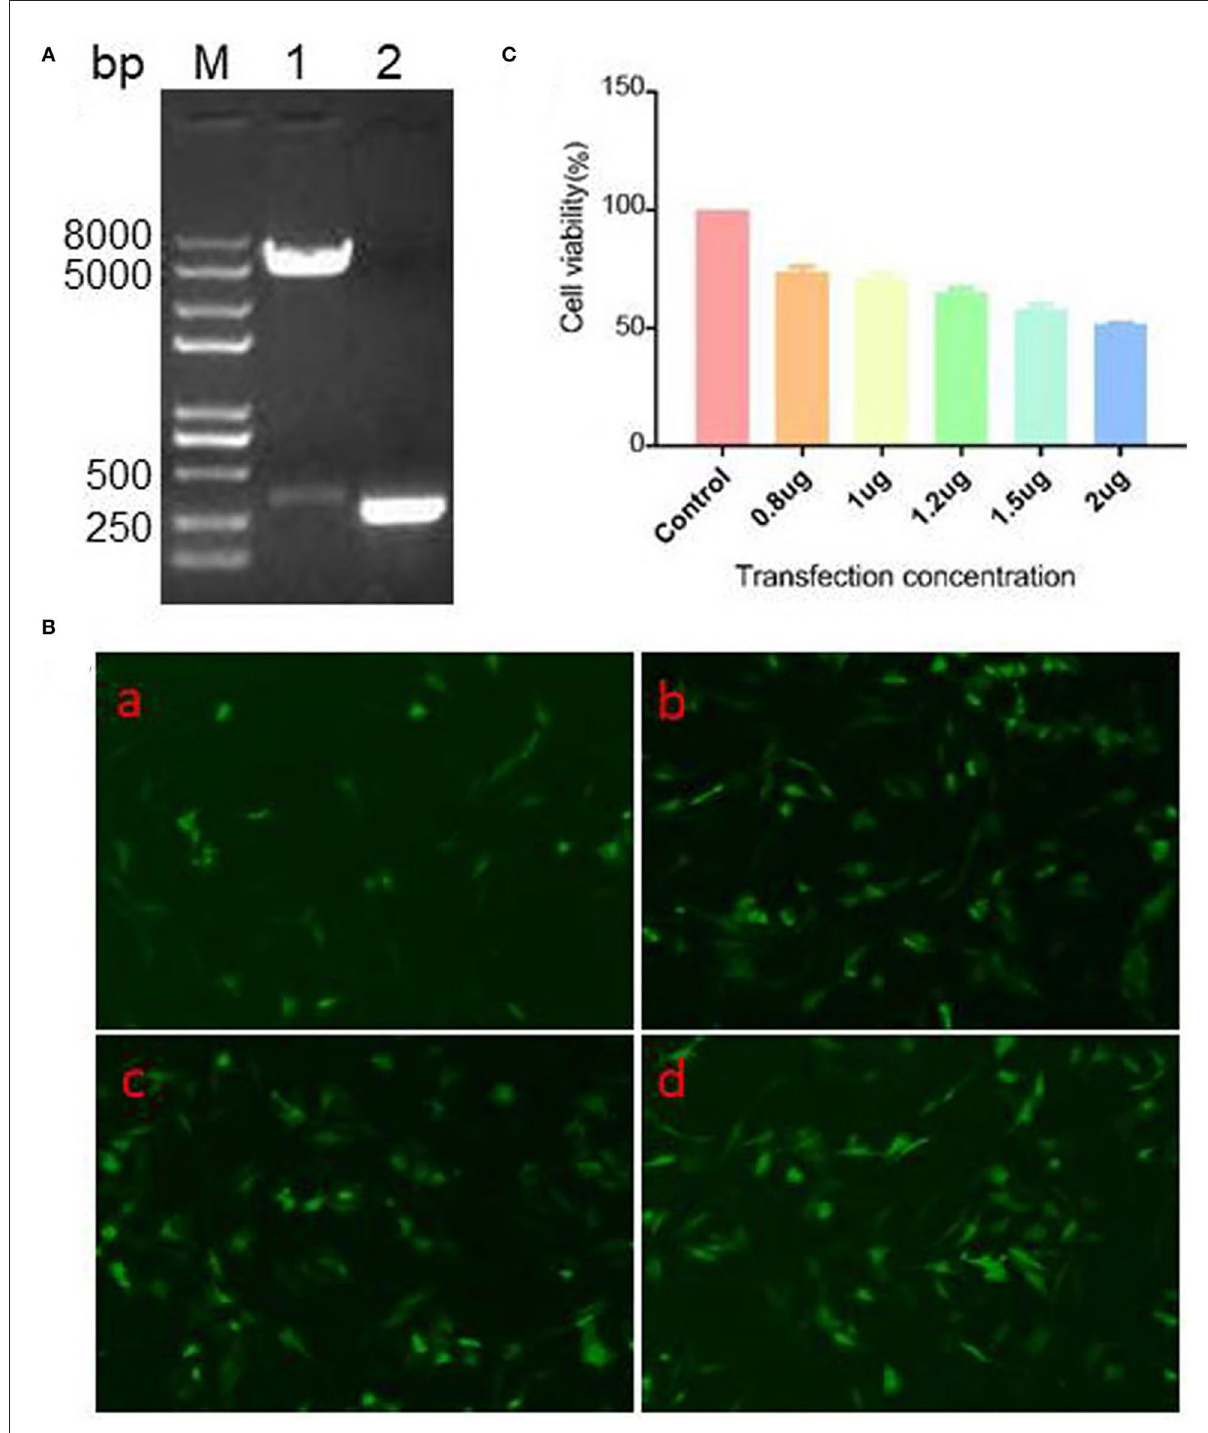
FIGURE2 Identification, expression efficacy, and cell viability on DF1 cells of pEGFP-N1/CCL19. (A) PCR and double restriction enzyme digestion identification of eukaryotic expression vector pEGFP-N1/CCL19. Lane M: Trans 2K Plus II DNA marker; Lane 1: double enzymes digestion; Lane 2: PCR of CCL19. (B) Different concentrations (0.5, 1.0, 1.5, and 2.0 µ g) of plasmid pEGFP-N1/CCL19 in DF1 cells were transfected into DF1 cells in (B) (a–d), respectively. (C) Effects of different concentrations of plasmid pEGFP-N1/CCL19 on cell viability. Concentrations of 0.8, 1.0, 1.2, 1.5, and 2.0 µ g plasmids were transfected in DF1